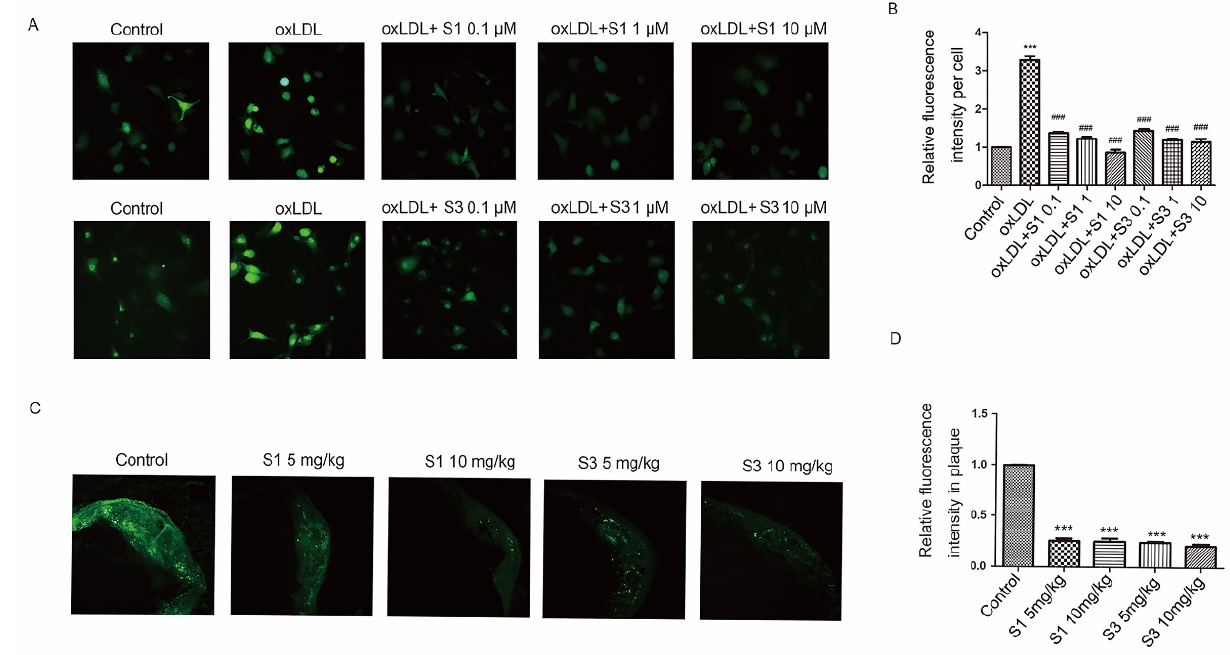
Figure 5. Effects of compounds S1 and S3 on the increased ROS level in oxLDL ‐ stimulated HUVECs and plaque of apoE ‐ / ‐ mice. ( A ) HUVECs were treated with oxLDL (50 μ g/mL), oxLDL and indicated compounds for 6 h. The ROS level in HUVEC was determined by DCHF probes (200×). ( B ) The quantification of ROS level in different group. Data were analyzed using one ‐ way ANOVA with Bonferroni correction. *** p < 0.001 vs. control, ### p < 0.001 vs. oxLDL, n = 3. ( C ) Sections of aortic roots from different apoE ‐ / ‐ mice group were incubated with DCHF probe to detect ROS level of plaque. ( D ) The quantification of ROS level in plaque. Data were analyzed by an unpaired two ‐ sided Student’s t ‐ test. *** p < 0.001 vs. control, n = 6 mice per group.